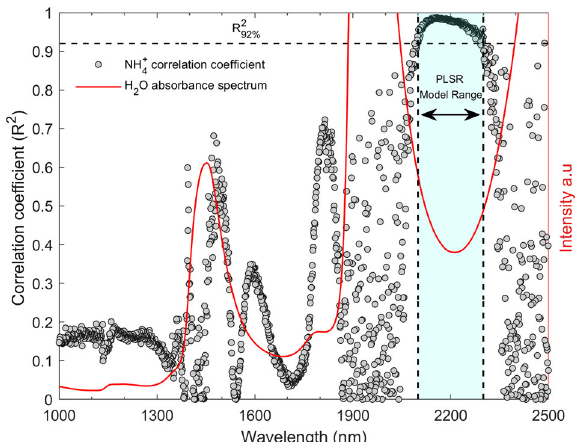
Fig. 1 De fi ning the prediction model boundaries. Left y axis: correlation values between ammonium concentration and absor- bance values for each speci fi c wavelength. Right y axis: water absorption in the NIR